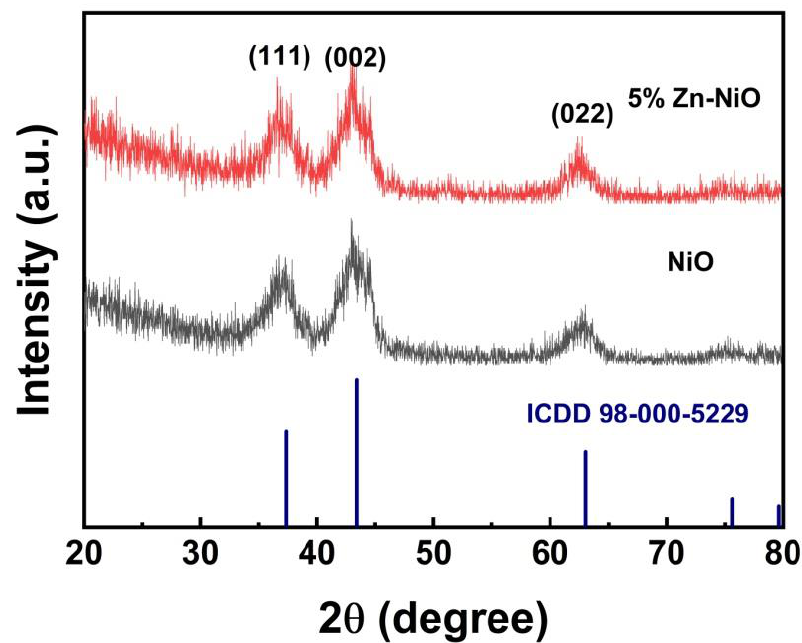
Figure 4. XRD patterns of NiO x and 5% Zn-NiO x thin films.